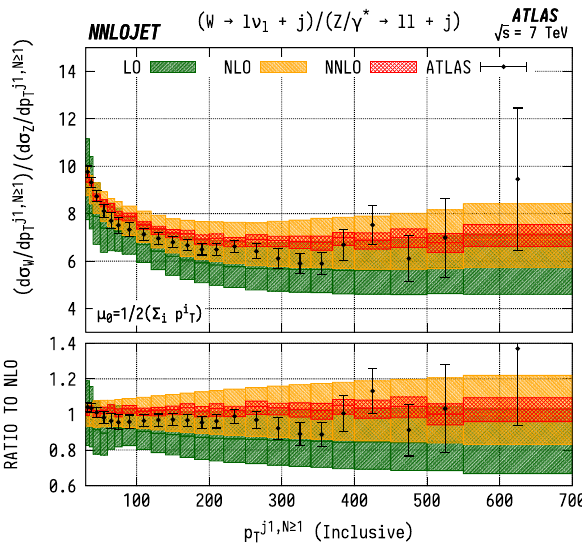
Fig. 19 Ratio of exclusive/inclusive ( N = 1 / N ≥ 1 ) ZJ production differential in the transverse momentum p T of the leading jet. Errors on the ATLAS data are approximated using uncertainties from the N = 1 distribution normalised to the N ≥ 1 results. See Fig. 15 for details